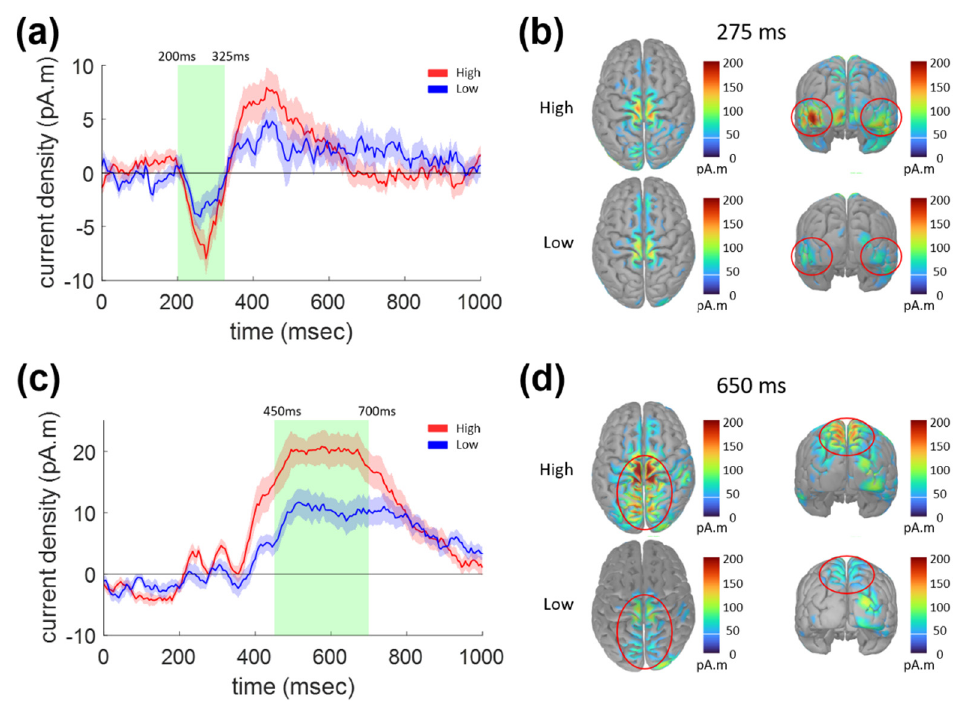
Figure 3. ERCD waveforms for the sudden stop task (0–1000 ms) and the distribution of current source density on cortical surface. ( a ) ERCD waveforms averaged over the vertices belonging to lateral occipital regions. ( b ) Distribution of ERCD on cortical surface at 275 ms. ( c ) ERCD waveforms averaged over the vertices belonging to superior parietal regions. ( d ) Distribution of ERCD on cortical surface at 650 ms.